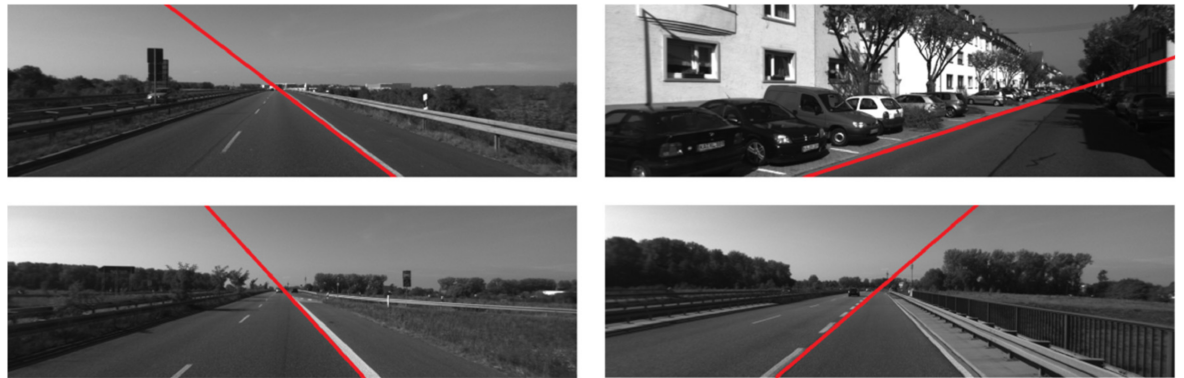
Figure 14. Example frames of the KITTI odometry